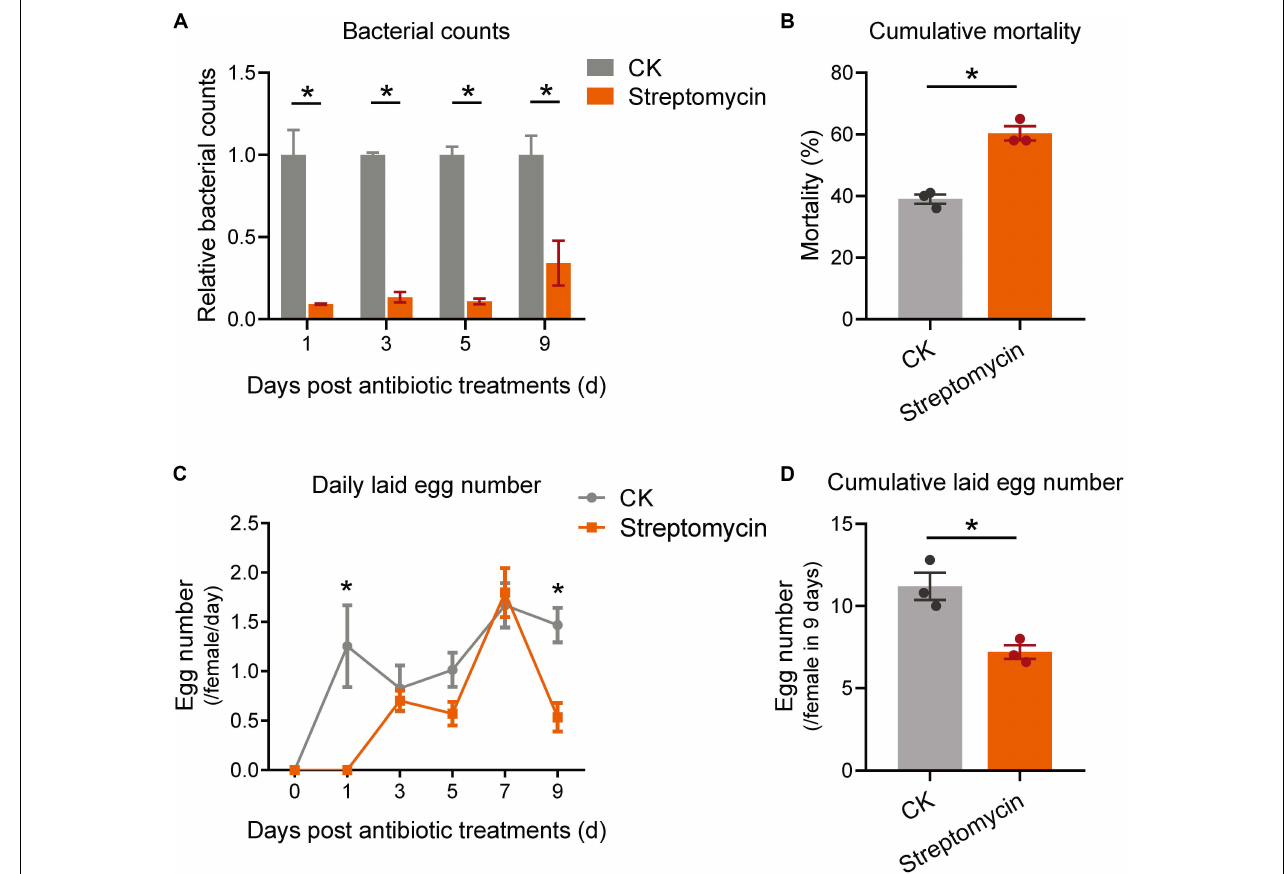
FIGURE 7 | The effects of antibiotic-treatments on the survival and reproduction of P. citri . After treatment of streptomycin (3 mg/ml), the relative bacterial counts (A) , cumulative mortalities (B) , daily (C) , and cumulative laid egg number (D) were detected and compared to that of control (CK). All n = 3. The bacterial counts at each time point in (A) were normalized to the mean of CK to calculate the relative bacterial counts. *Indicated the significant difference between streptomycin treatment and CK. Plots showed means ±